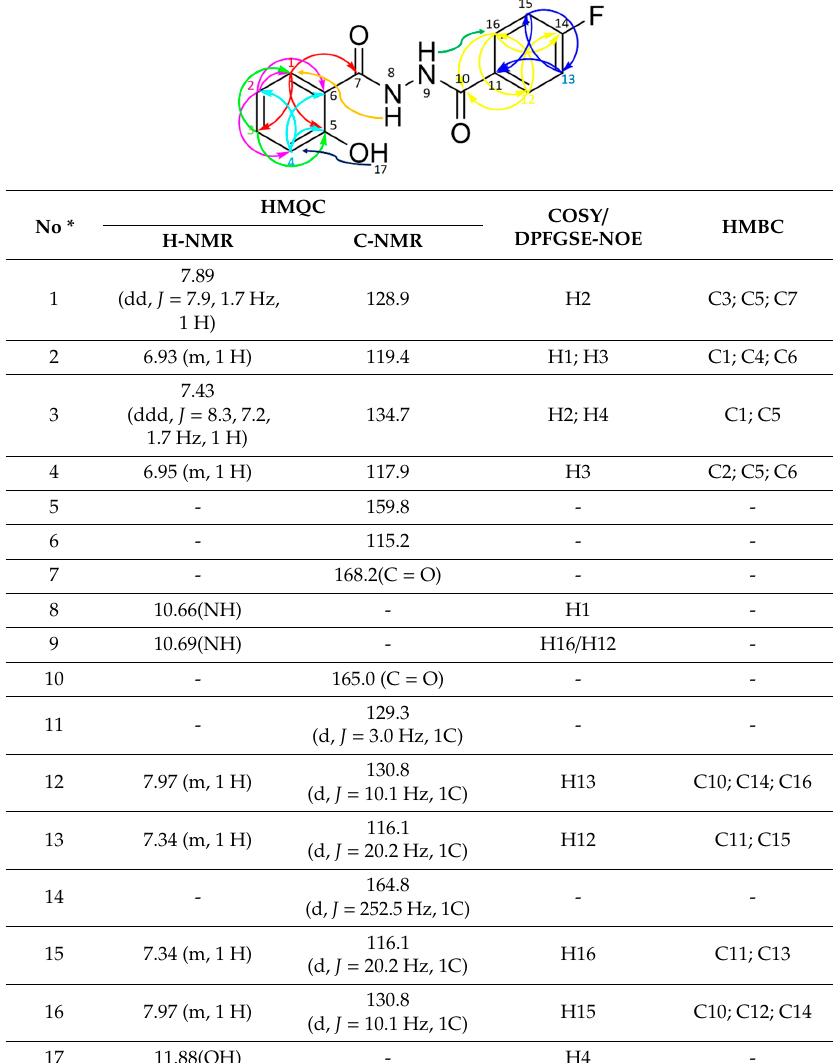
Table 1. Cross-peaks in COSY, DPFGSE-NOE, HMBC, and HMQC of compound ( 3 ).